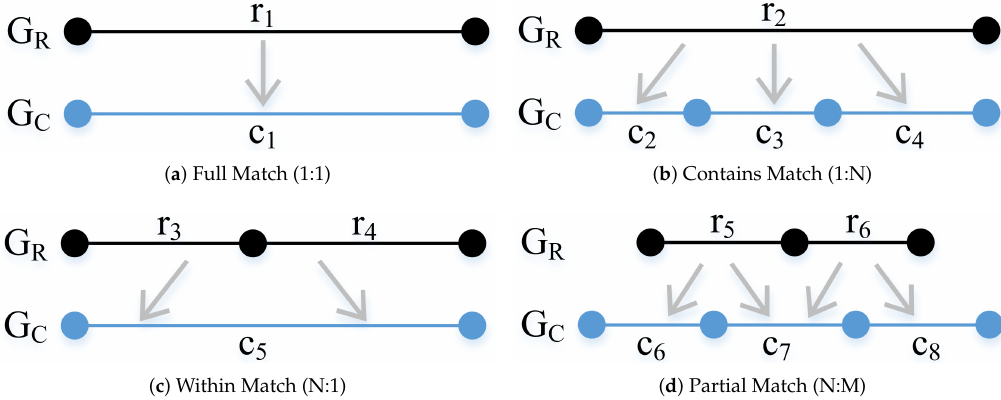
Figure 4. Cardinalities of matching